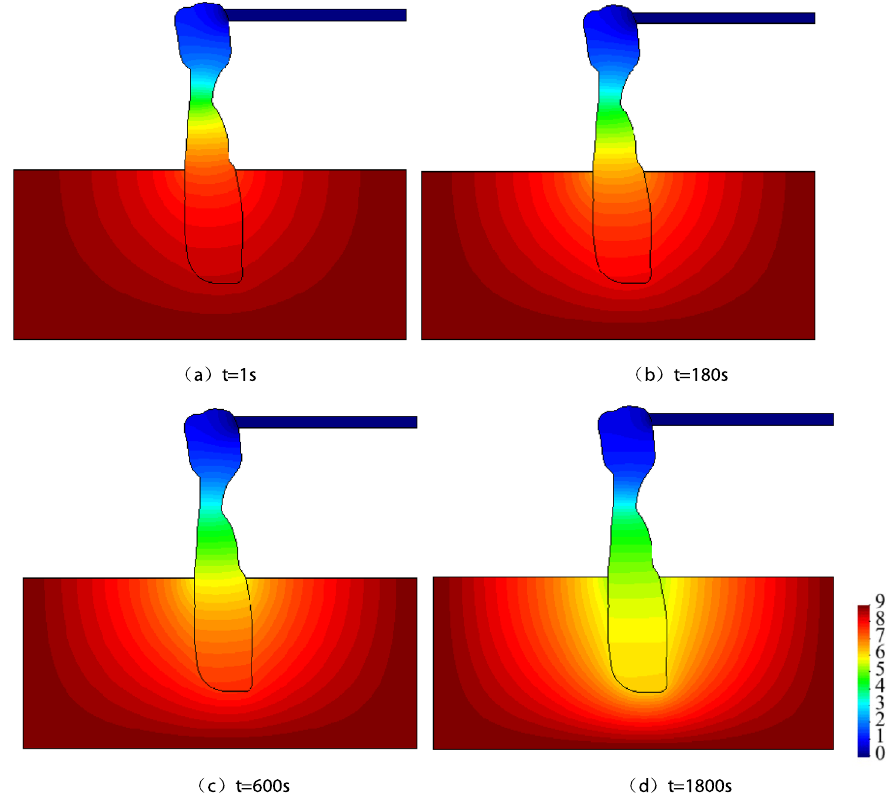
Figure 7. Space–time evolution process of pressure (unit: MPa).